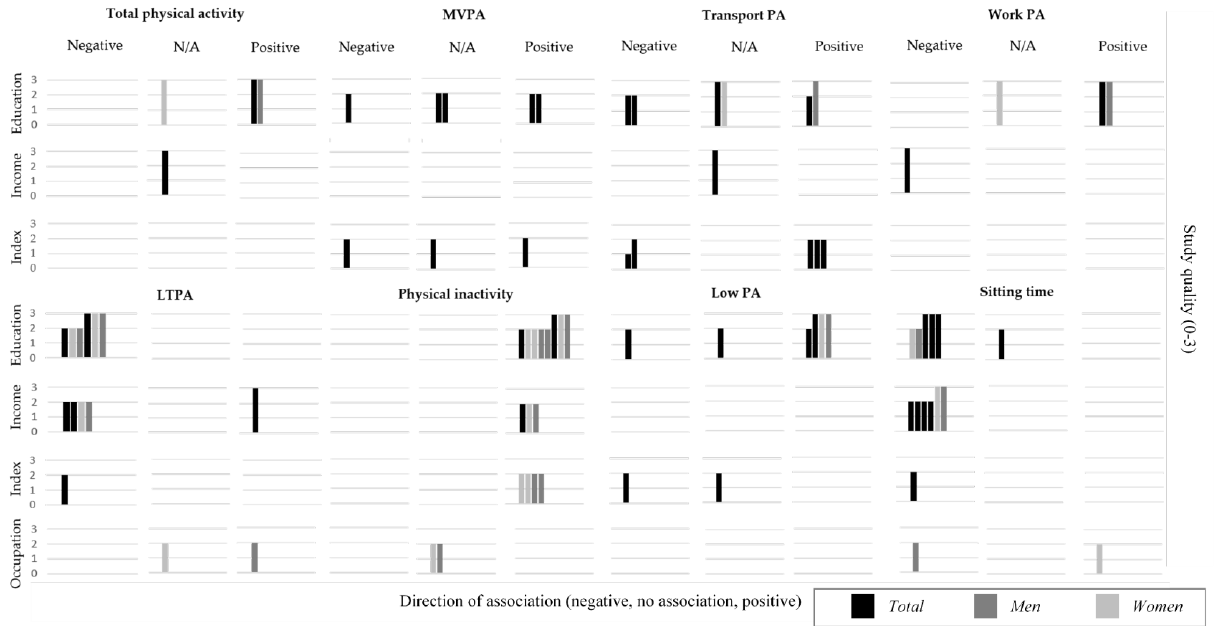
Figure 3. Summary of evidence for associations between socioeconomic position and physical activity and sedentary behaviour. Each row represents a dimension of socioeconomic position, and each column represent the direction of the association between socioeconomic position indicators and physical activity and sedentary behaviour measurement. Relative differences ≥ 10% or OR<0.80 were categorised as negative association (lower activity among lower SEP groups, compared to the higher) or positive association (higher activity among lower SEP groups, compared to the higher). Relative differences <10% were classified as no association (N/A). Each bar represents an association between SES and physical activity or sedentary behaviour. The quality assessment scores from the articles are indicated by the height of the bars (1 = Quality scores ≤ 4.5; 2 = Q.S.>4.5 and <7; 3 = Q.S. ≥ 7). Studies conducted among adults are indicated with full-tone (black) bars, only adult men are presented half-tone (grey) and adult women with quarter-tone (light grey). PA: Physical Activity; MVPA: Moderate and/or vigorous PA; LTPA: Leisure-time